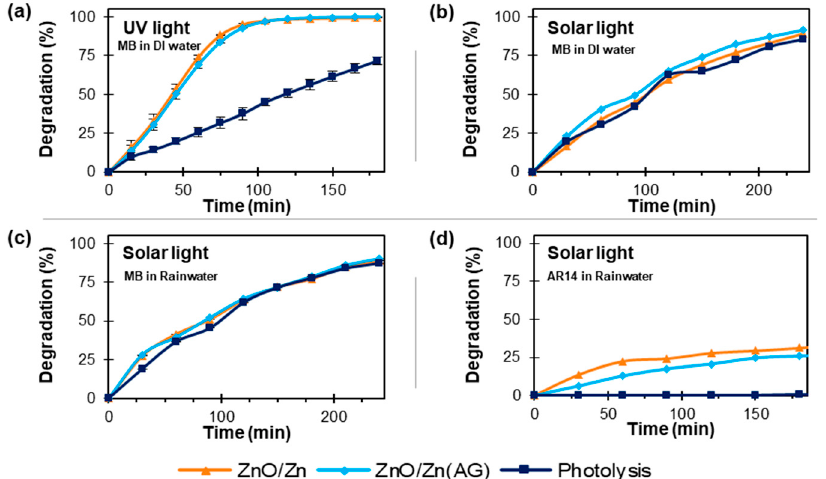
Figure 3. MB photodegradagtion with and without ZnO NSs under ( a ) UV light source (~365 nm, 35 mW/cm 2 ) in DI Water, ( b ) natural solar light (April/May, France, I UV = 2.3 mW/cm 2 ) in DI Water, and ( c ) natural solar light (April/May, France, I UV = 2.3 mW/cm 2 ) in rainwater; ( d ) AR14 photodegradation with and without ZnO NSs under natural solar light (April/May, France, I UV = 2.9 mW/cm 2 ) in rainwater.